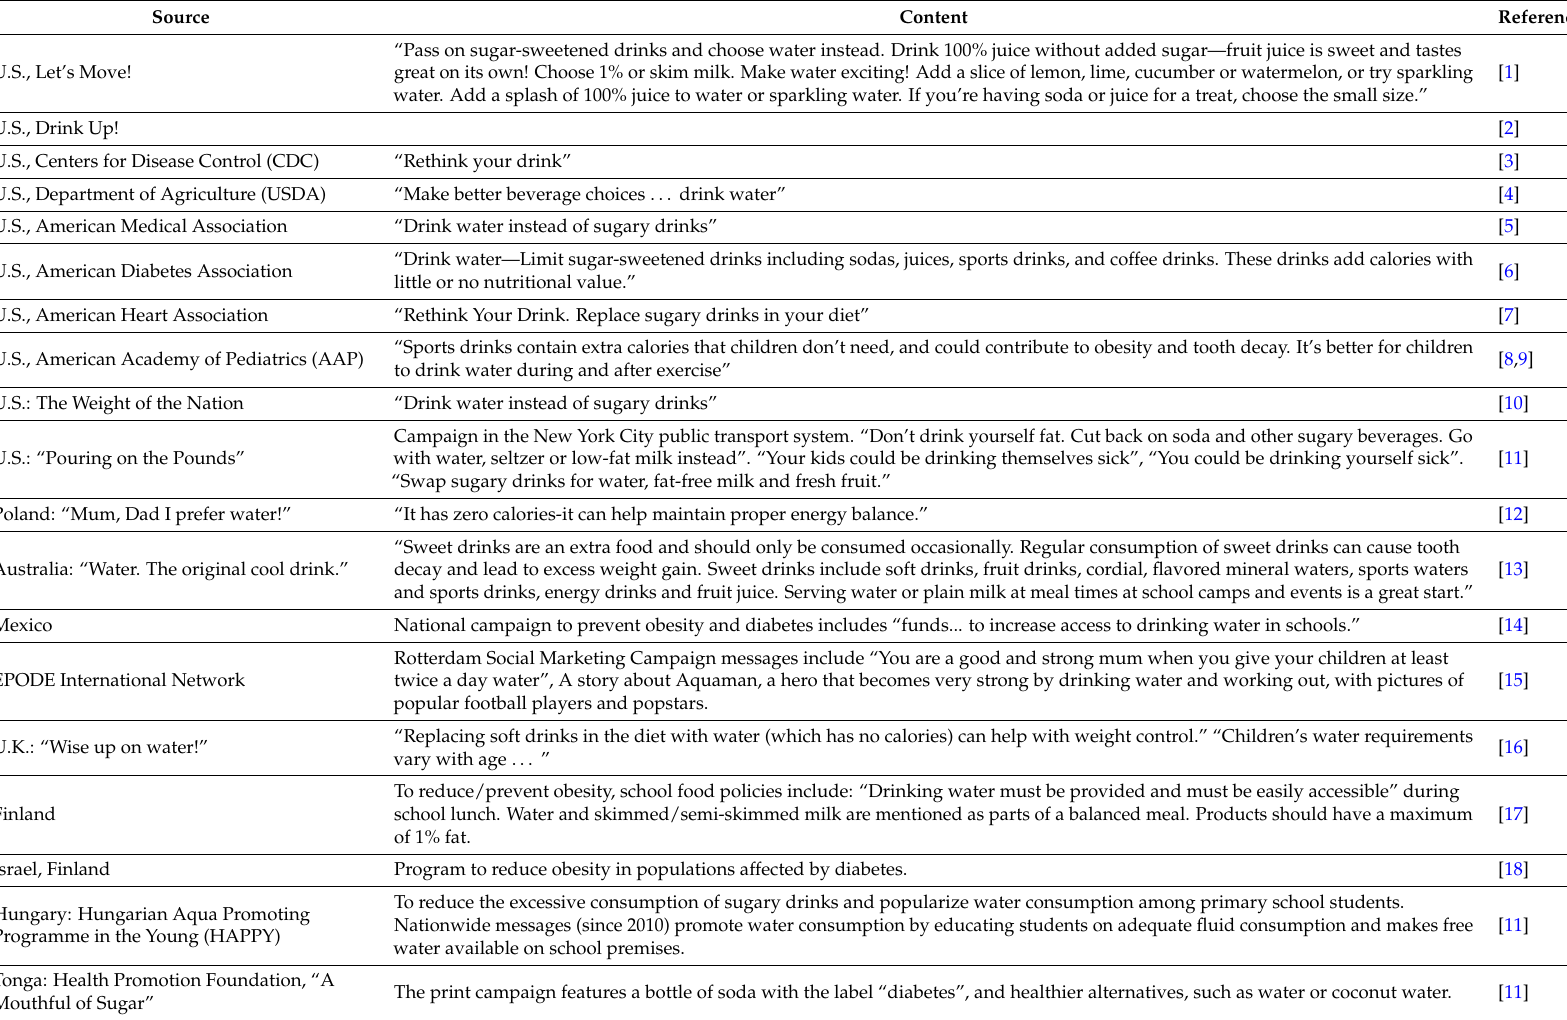
Table 1. Example recommendations to drink water for weight